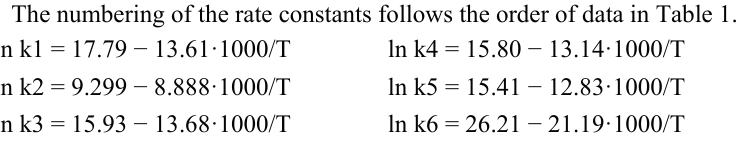
Figure 2. Arrhenius plots for the available data